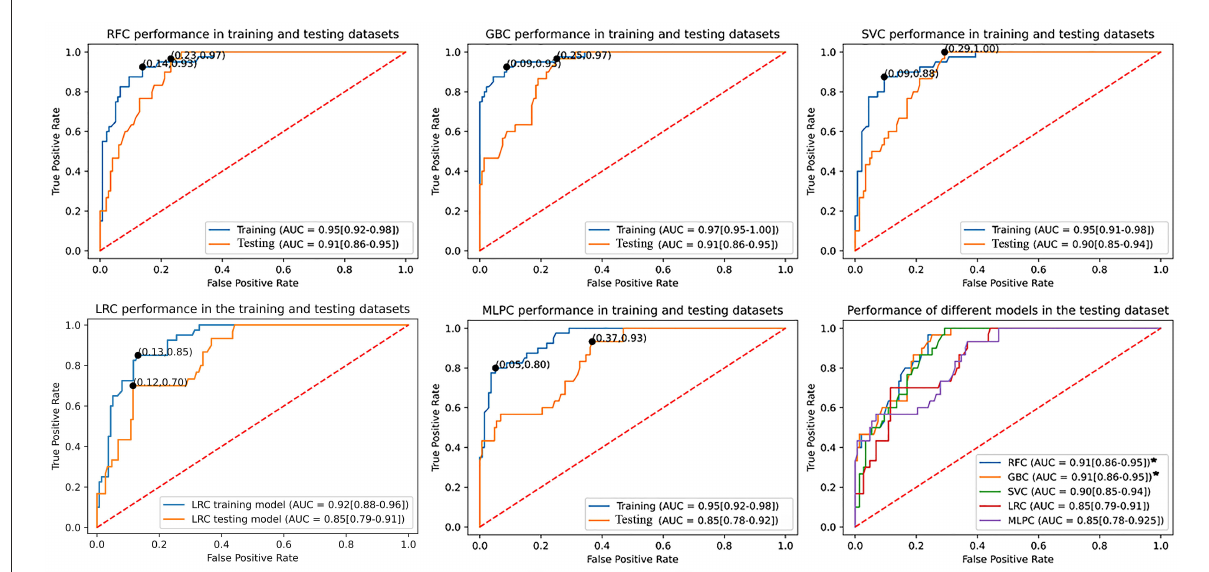
FIGURE2 Comparison of the utilized machine learning models’ overall performance using the AUC ± 95% CI metric. Youden indices were estimated using the maximum sensitivity plus specificity. The RFC and GBC models demonstrated significantly larger AUC compared to LRC and MLPC but with no statistical difference between each other and SVC. AUC, area under curve; CI, confidence interval; SVC, support vector classifier; GBC, gradient boosting classifier; LRC, logistic regression classifier; RFC, random forest classifier; MLPC, multilayer perceptron